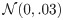
1000 agents, four two-topic copulas, 50000 iterations, μ = .4, d = .26, noise from N(0,.03)—(11) Frank, (21) Clayton, (31) Gumbel, (41) Ordinal sum.(12, 22, 32, 42) Final state: uni- variate, (13, 23, 33, 43) Marginals in time: univariate, (14, 24, 34, 44) Final state: bivariate, (15, 25, 35, 45) Marginals in time: bivariate.